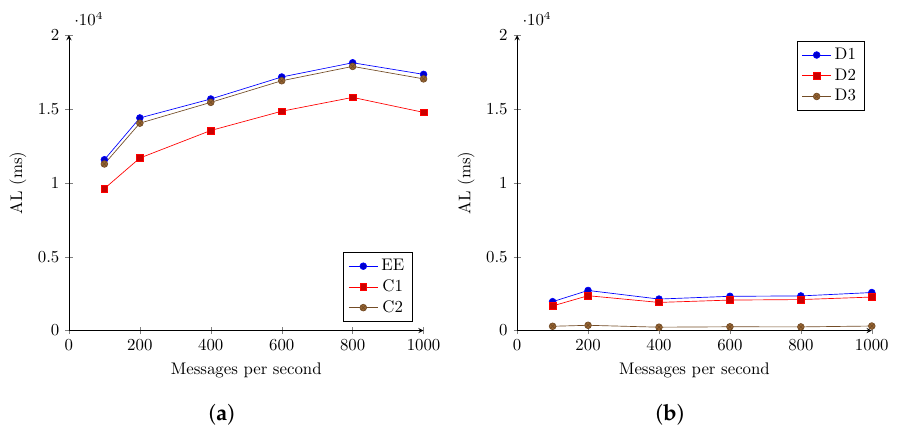
Figure 7. AL registered for the second stage evaluation. LoRaWAN for 100 simulated devices. ( a ) Registered latencies for monitored components and end to end. ( b ) Differences in recorded latencies between